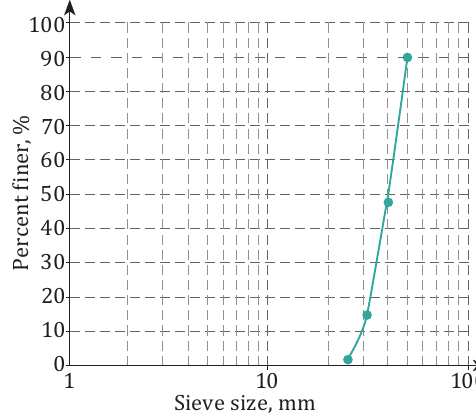
Figure 4. Particle size distribution curve for